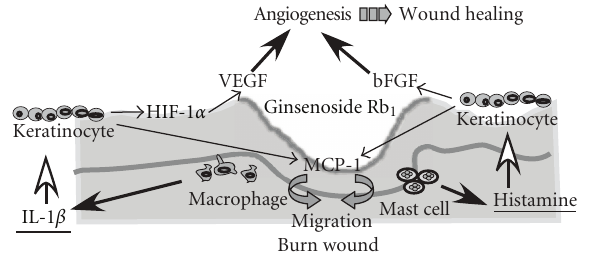
Figure 8: The proposed mechanisms of the enhancing e ff ects of ginsenoside Rb 1 on burn wound healing.